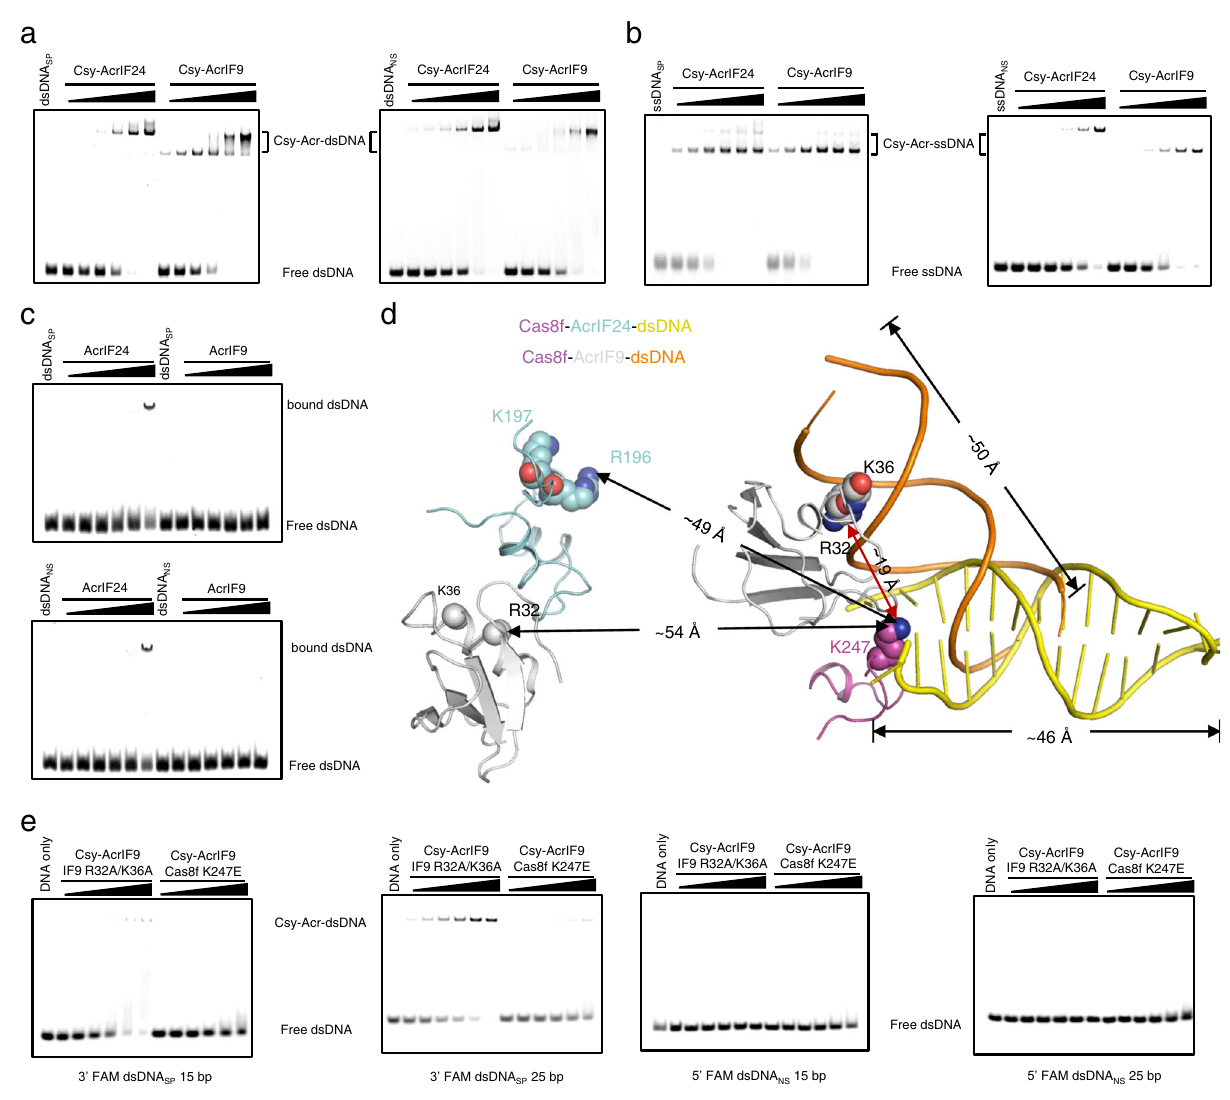
Fig. 9 AcrIF24 and AcrIF9 show different characteristics in inducing non-speci fi c DNA binding. a – b EMSA used to test the non-speci fi c DNA binding af fi nity and mode of Csy-AcrIF24 and Csy-AcrIF9 using dsDNA SP /dsDNA NS ( a ), or ssDNA SP /ssDNA NS ( b ). Reactions were performed as in Fig. 5c. c EMSA used to test the binding ability of AcrIF24 and AcrIF9 using dsDNA SP or dsDNA NS . Reactions were performed as in Fig. 5c. d Structural superimposition of the Csy-AcrIF24-dsDNA SP and Csy-AcrIF9-dsDNA NS complexes. Only the Cas8f, Acr, and dsDNA regions are shown. K247 of Cas8f and the residues involved in non-speci fi c DNA binding of AcrIF9 and AcrIF24 are shown in the sphere model. e EMSA was used to test the non-speci fi c DNA binding of Csy-AcrIF9 with mutations in AcrIF9 or Csy using 3 ′ FAM-labeled dsDNA SP or 5 ′ FAM-labeled dsDNA NS . Reactions were performed as in Fig. 5c. Please see the left two panels of Fig. 8c for the WT control of the experiments using 3 ′ FAM dsDNA SP 15 bp and 25 bp, respectively. Please see the left two panels of Fig. 8b for the WT control of the experiments using 5 ′ FAM dsDNA SP 15 bp and 25 bp,